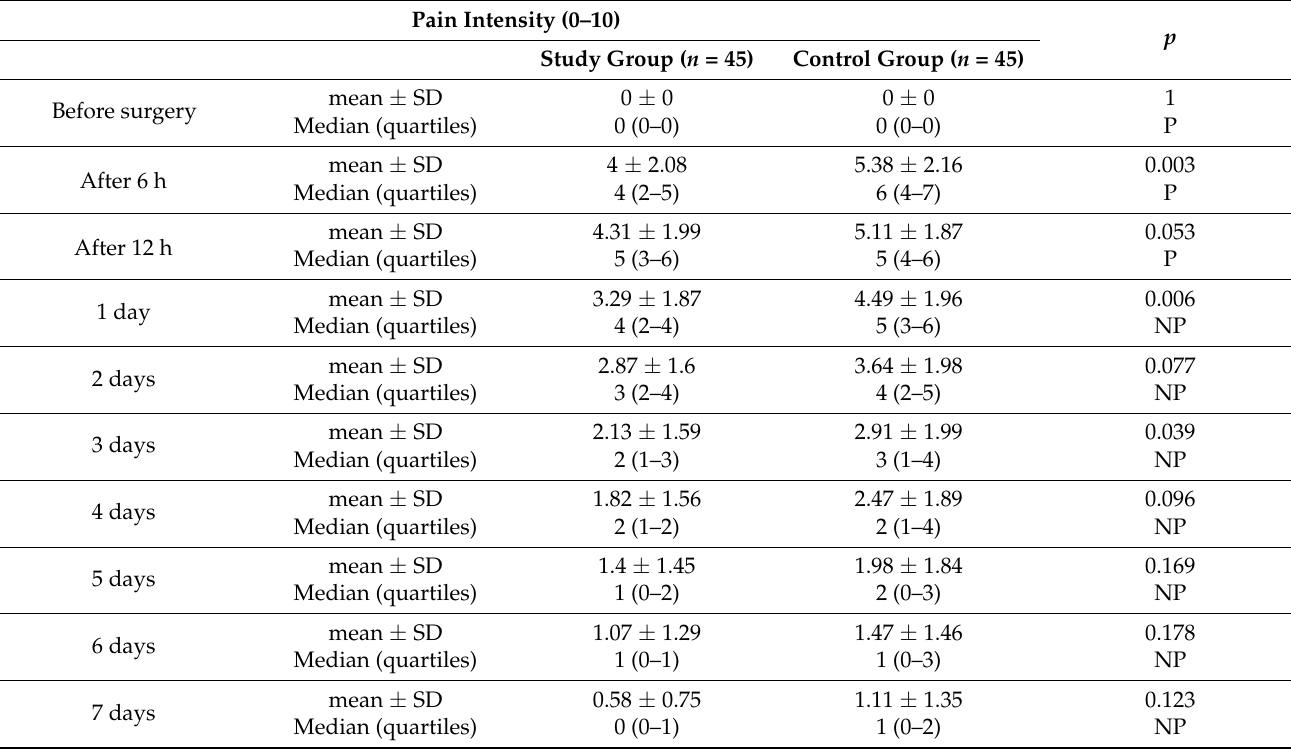
Table 4. Pain intensity at six and twelve hours after surgery and postoperative Days 1, 2, 3, 4, 5, 6, and 7 between the study and control groups.